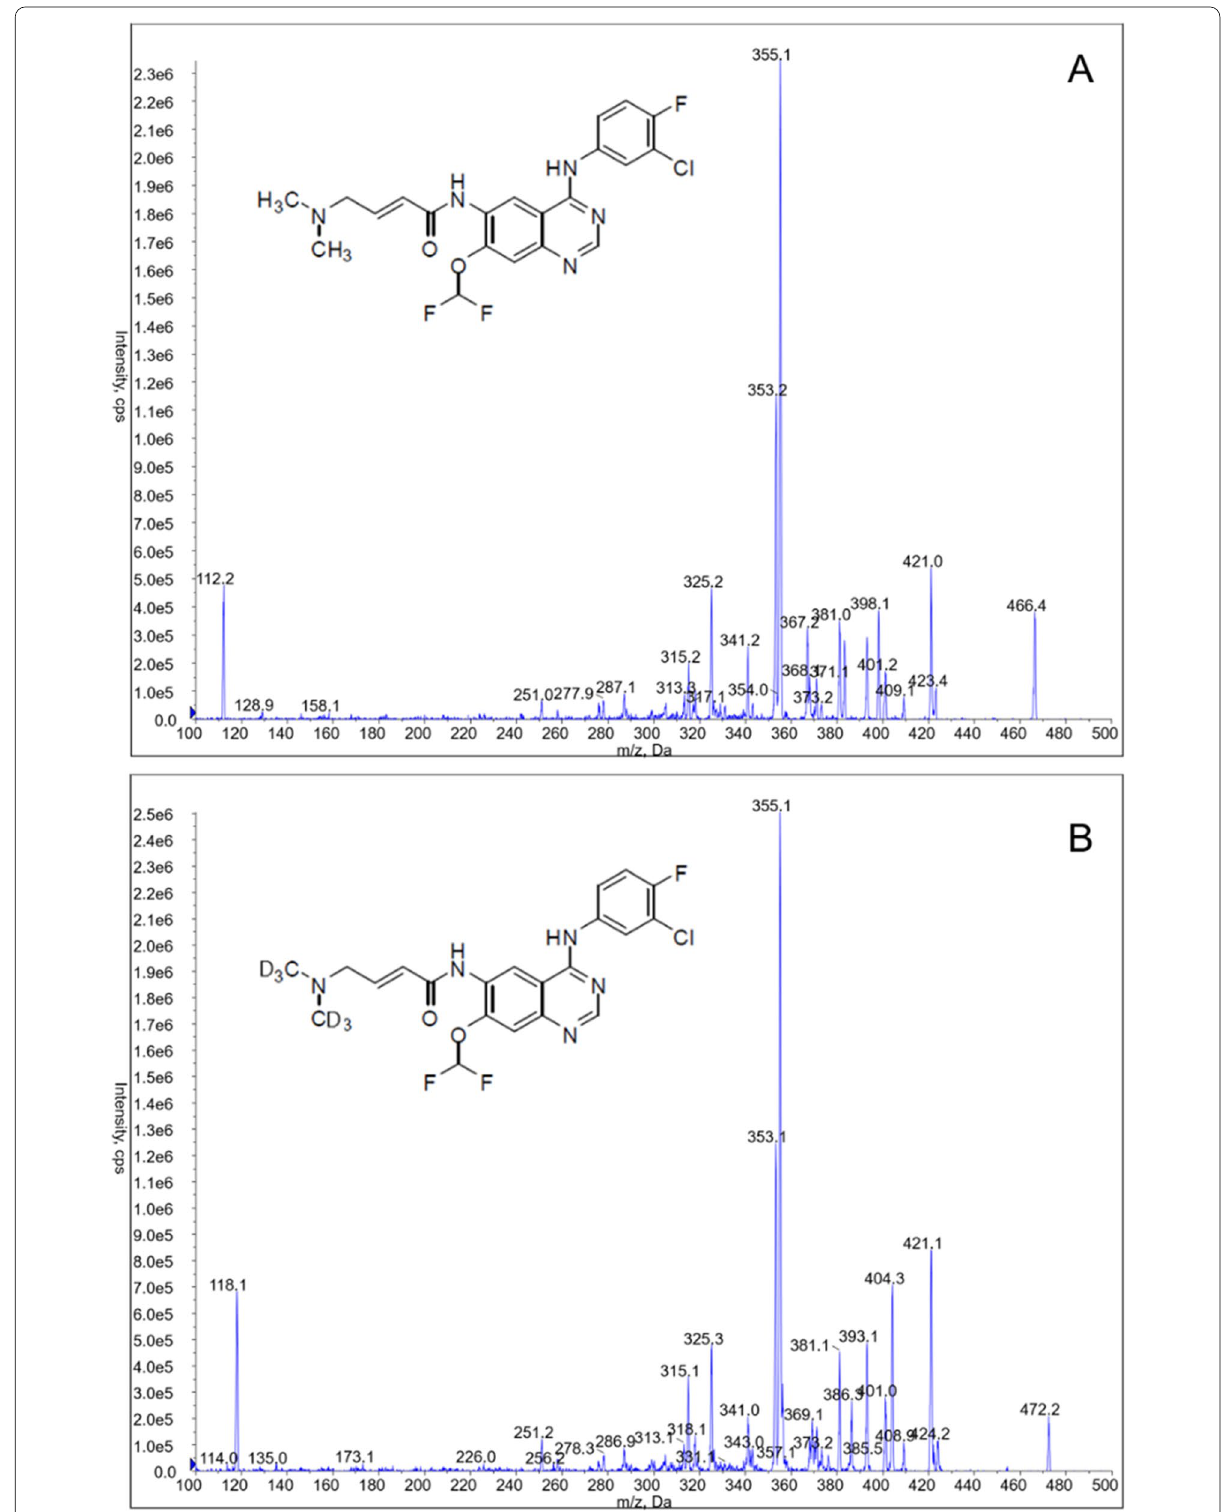
Fig. 1 The chemical structure and mass spectra of MET306 and IS. *The chemical structure and mass spectra of MET306 ( A ) and MET306-D 6 ( B